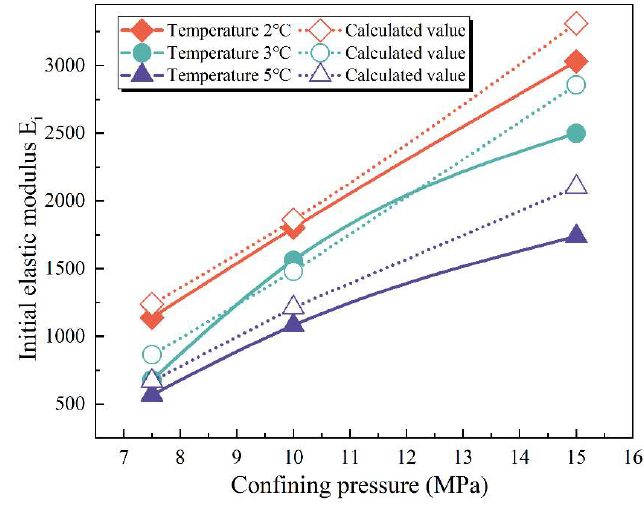
Figure 14. Fitting of initial elastic modulus E i .